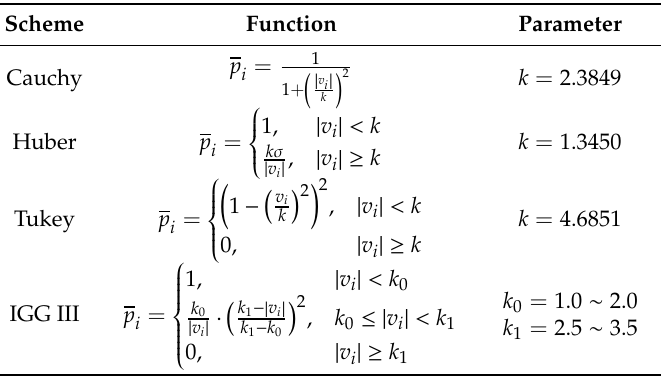
Table 1. Four representative score